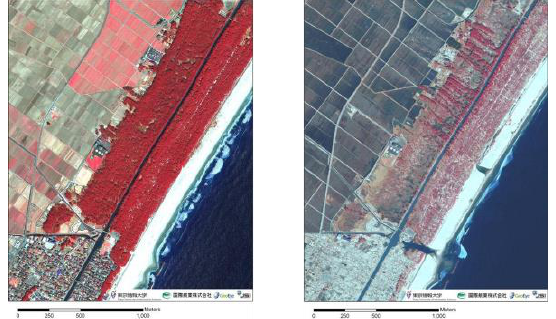
Figure 5(b). Zoom-in view of above GeoEye-1 images. R:G:B=4:3:2 (After Hara and Higuchi,